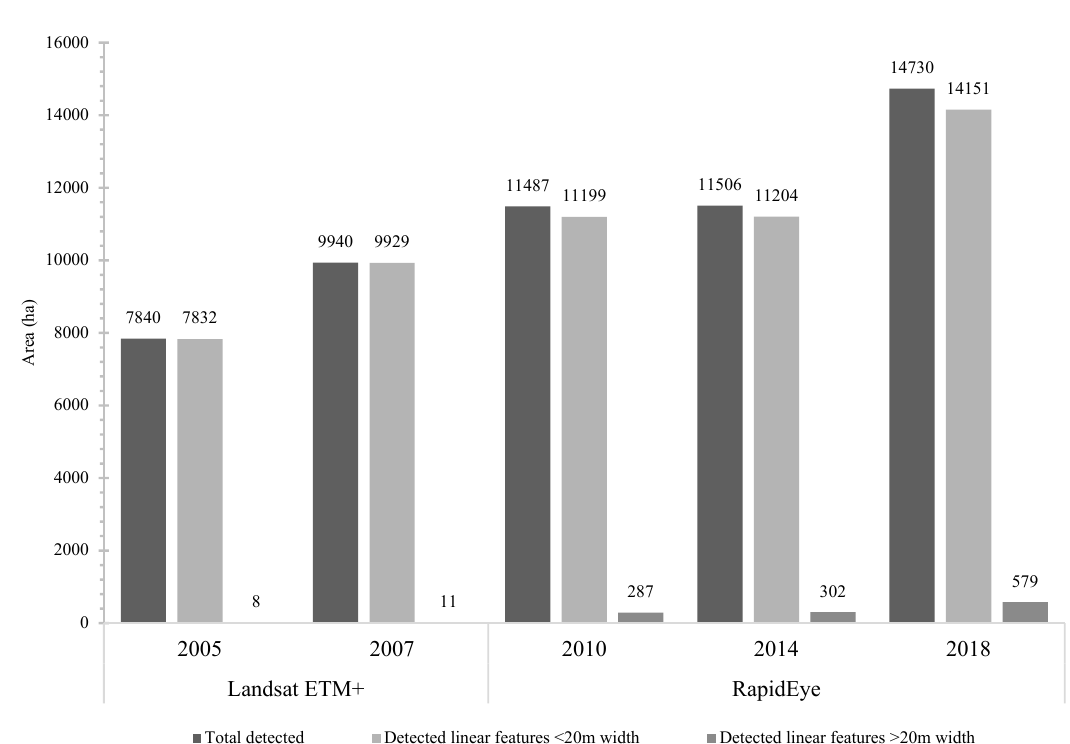
Figure 7. Bar graphs showing the dirt road and infrastructure expansion by width which are narrower/wider than 20 m. Each bar represents one of the classified 2–4 year interval time series imagery.